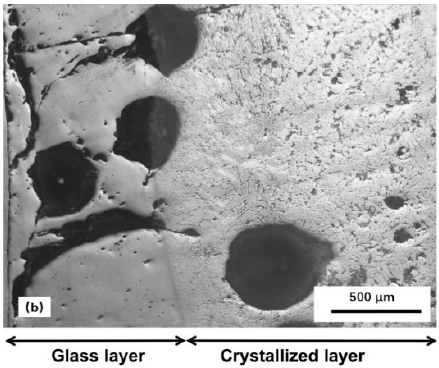
Figure 3. Cross sections of films recovered from the molten flux with 1623 K bulk temperature, after ( a ) 60 s and ( b ) 90 s of probe immersion. The left side of micrographs is the probe side; crystals started to precipitate around the edge of pores in ( a ). (Optical micrographs; black regions and spots are pores and cracks).